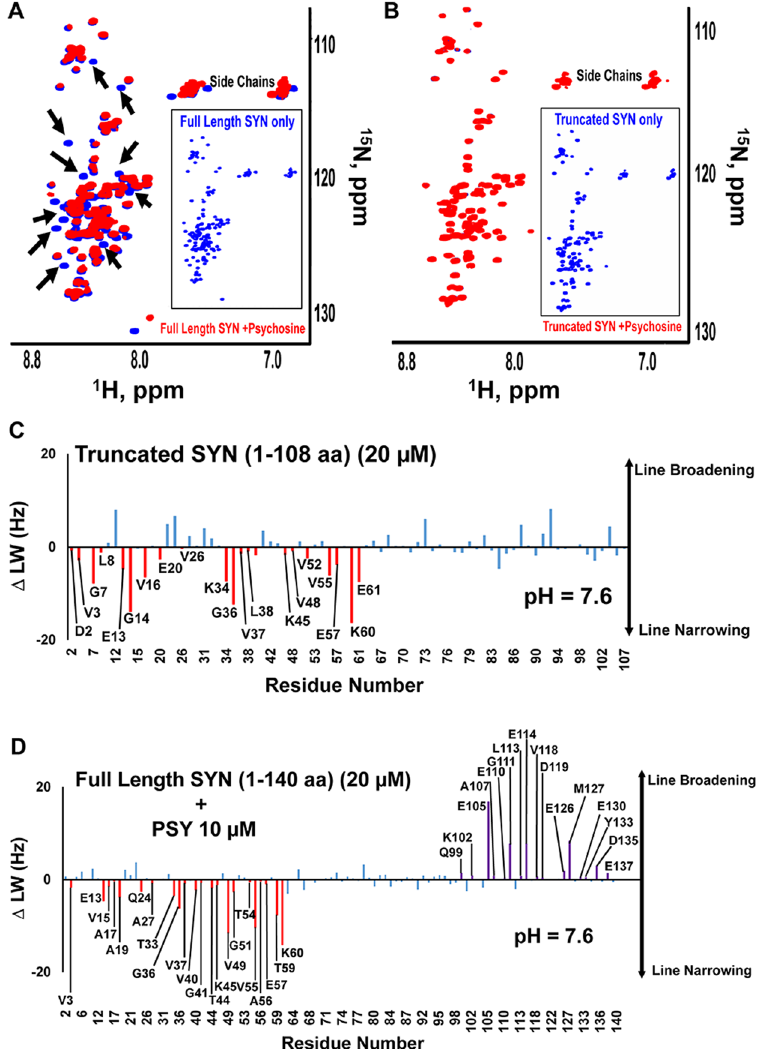
Figure 6. Psychosine interacts with α -synuclein at the C-terminus and truncation of or binding to the C-terminus of α -synuclein releases the N-terminus of α -synuclein. Overlays of 1 H 15 N-HSQC NMR spectra of full-length α -synuclein (20 µ M, blue) with psychosine (600 µ M, red) ( A ) and C-terminus truncated α -synuclein (20 µ M, blue) with psychosine (600 µ M, red) ( B ). Analysis of 15 N line-width differences ( Δ LW, Hz) between full-length α -synuclein and truncated α -synuclein ( C ) or full-length α -synuclein and α -synuclein in the presence of psychosine (10 µ M) ( D ) shows similar line-narrowing in the N-terminus and line-broadening in the C-terminus. Black arrows mark broadening in the signals of full-length α -synuclein in presence of psychosine. Full-length and truncated α -synuclein spectra are shown in boxes separately. Line-narrowing in the N-terminus is marked in red and line-broadening in the C-terminus in purple. SYN = α